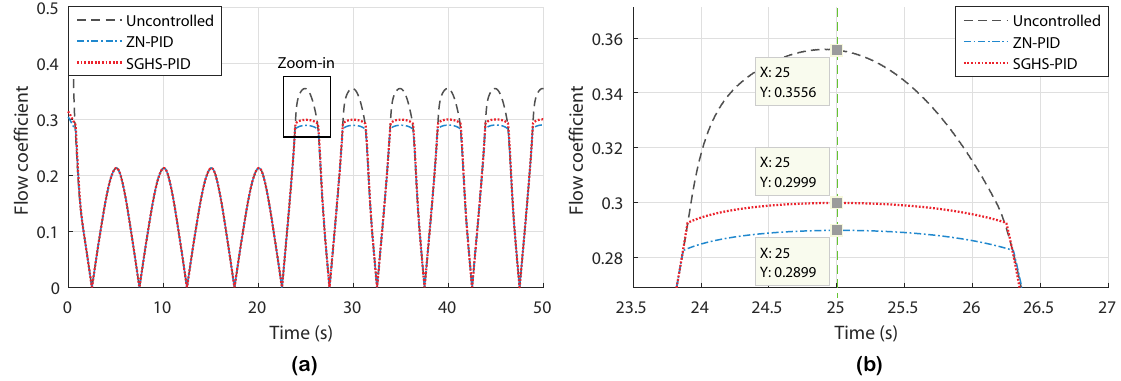
Figure 14. Flow coefficients of the OWC in uncontrolled and controlled cases. ( a ) Flow coefficients versus time. ( b ) Zoom-in section of the flow